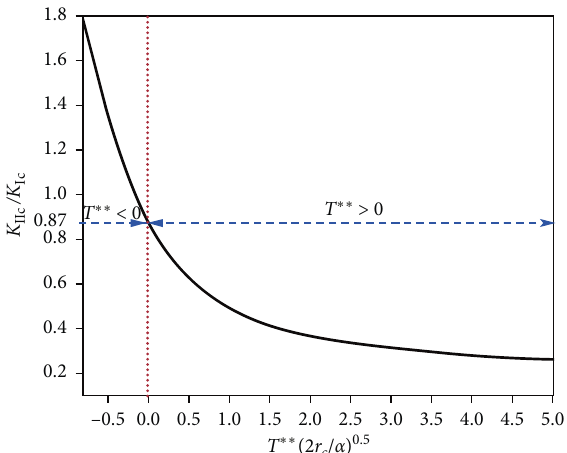
Figure 8: The fracture toughness ratio K IIc / K Ic of SCB specimen according to modified MTS